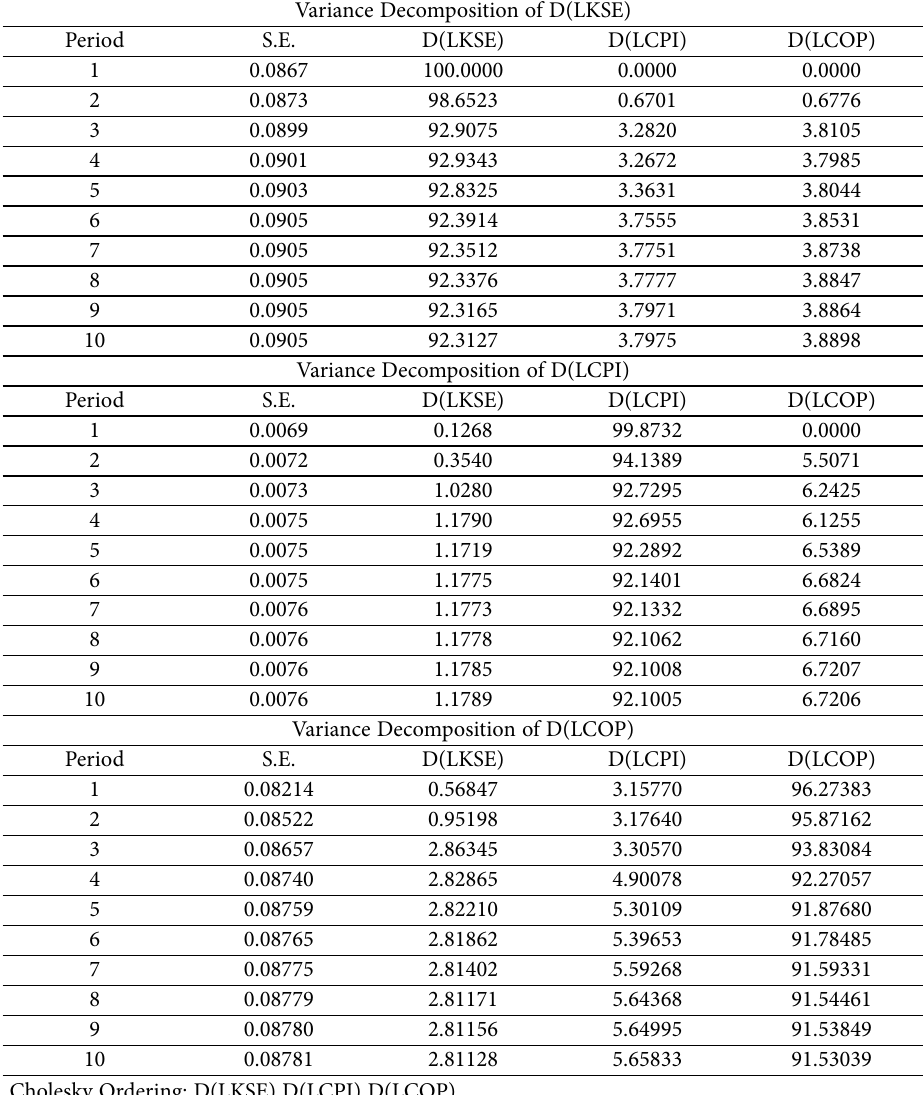
Table 6. Variance Decomposition – D(LKSE), D(LCPI) &